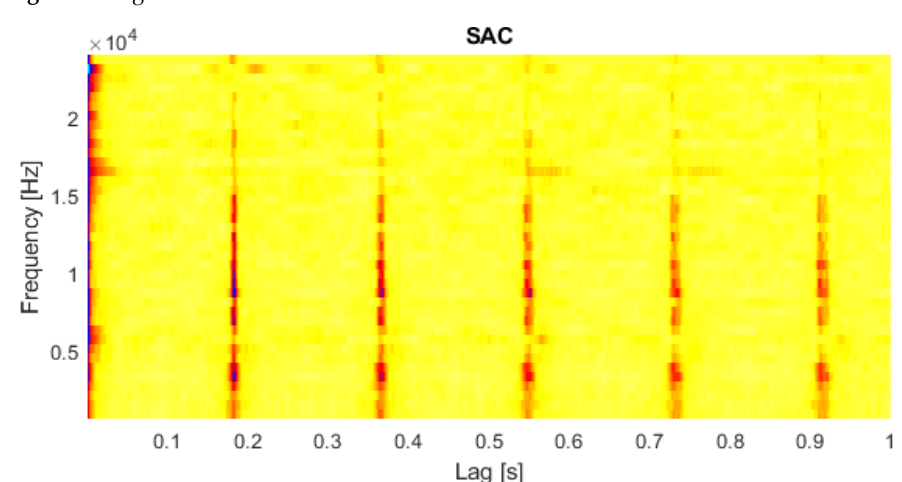
Figure 11. Signal denoised with LMD.